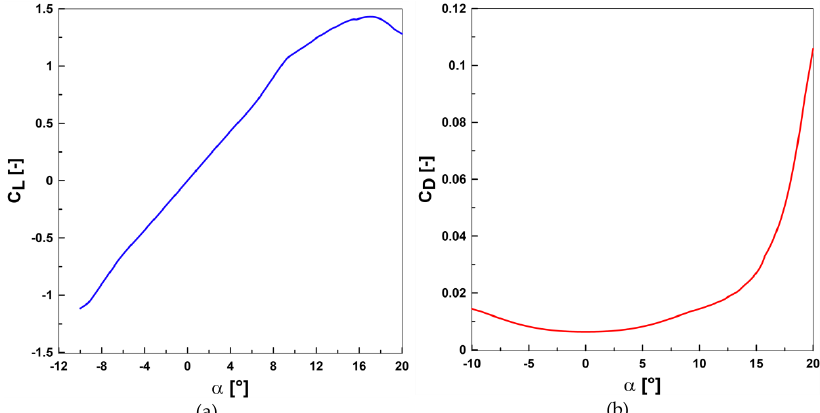
Figure 10. ( a ) Lift coefficient versus angle of attack alpha of NACA 0015 airfoil at R e = 10 6 ; ( b ) Drag coefficient versus angle of attack alpha of NACA 0015 airfoil at R e = 10 6 . Table 3. Influential geometric parameters for aerodynamic